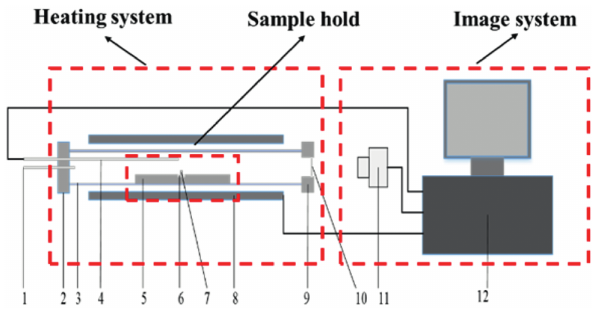
Figure 1: Melting features measurement system. 1-Gas inlet, 2-Iron valve, 3-Alumina tube, 4-Thermolcouple, 5-Corumdum, 6-Spacer, 7-Sample, 8-C-Si tube, 9-Iron valve, 10-glass, 11-Video camera, 12-data